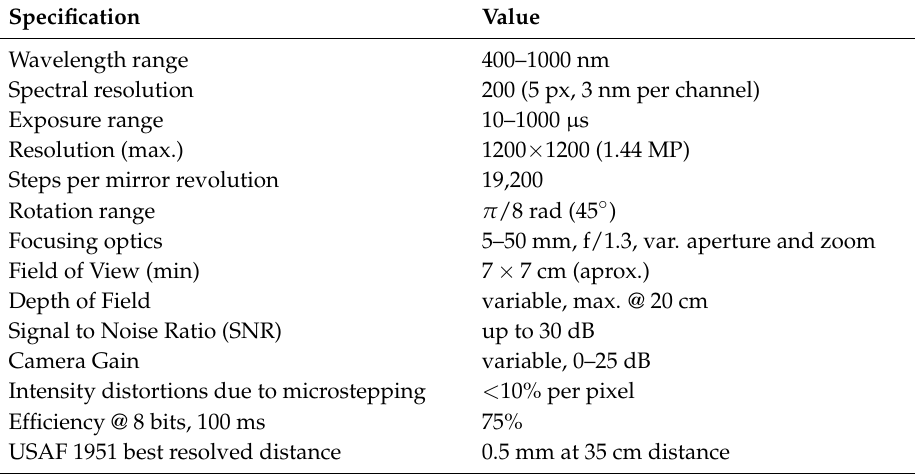
Table 7. Specifications of the custom-built imaging